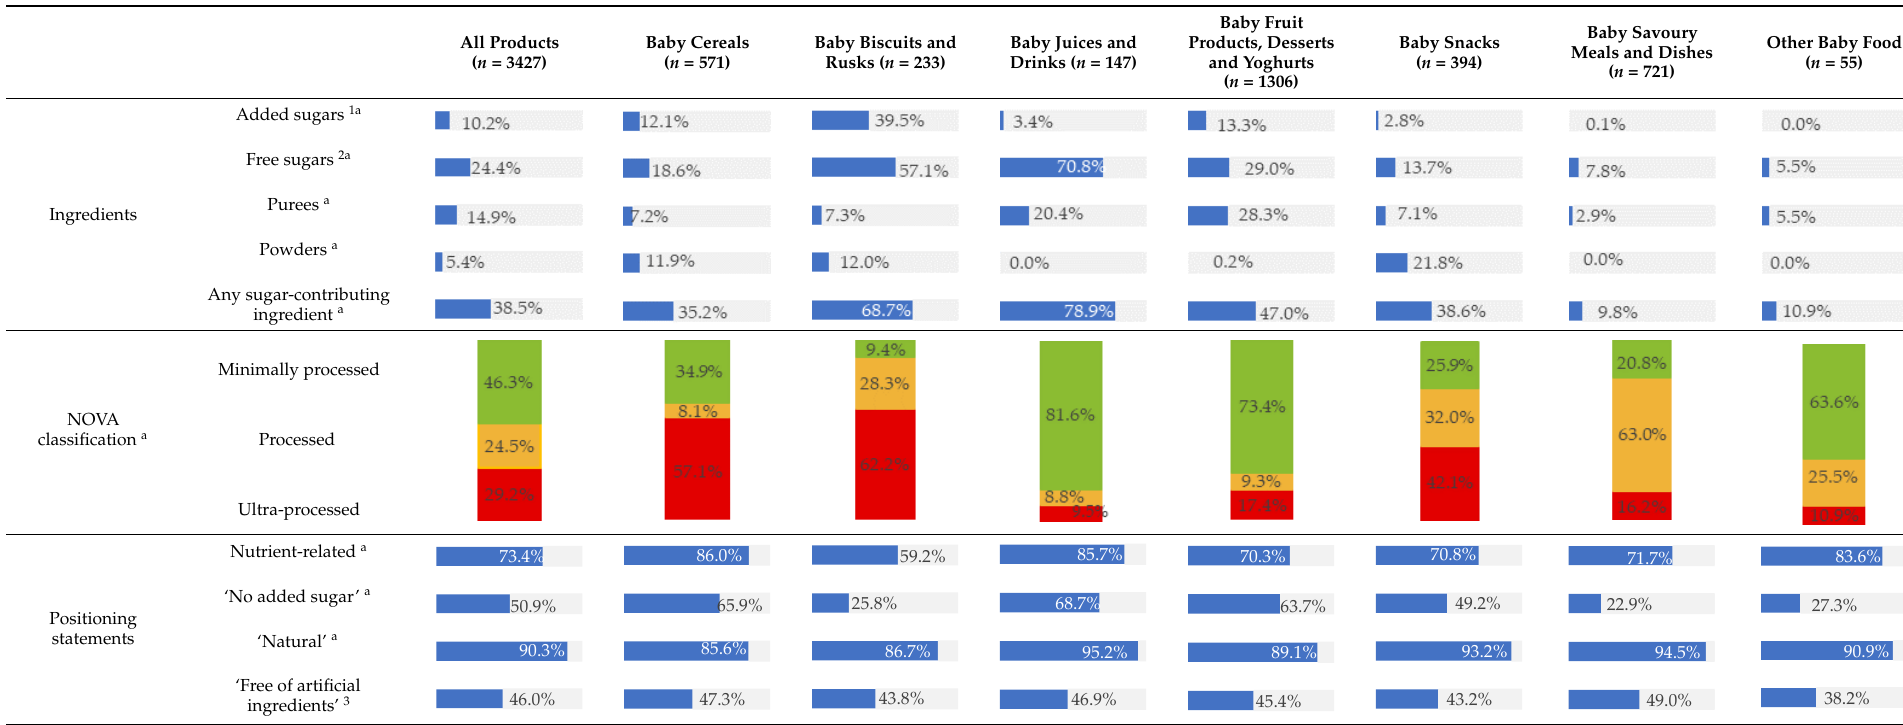
Table 2. Description of food products according to presence of sugar-contributing ingredients, NOVA classification system score and presence of positioning statements.